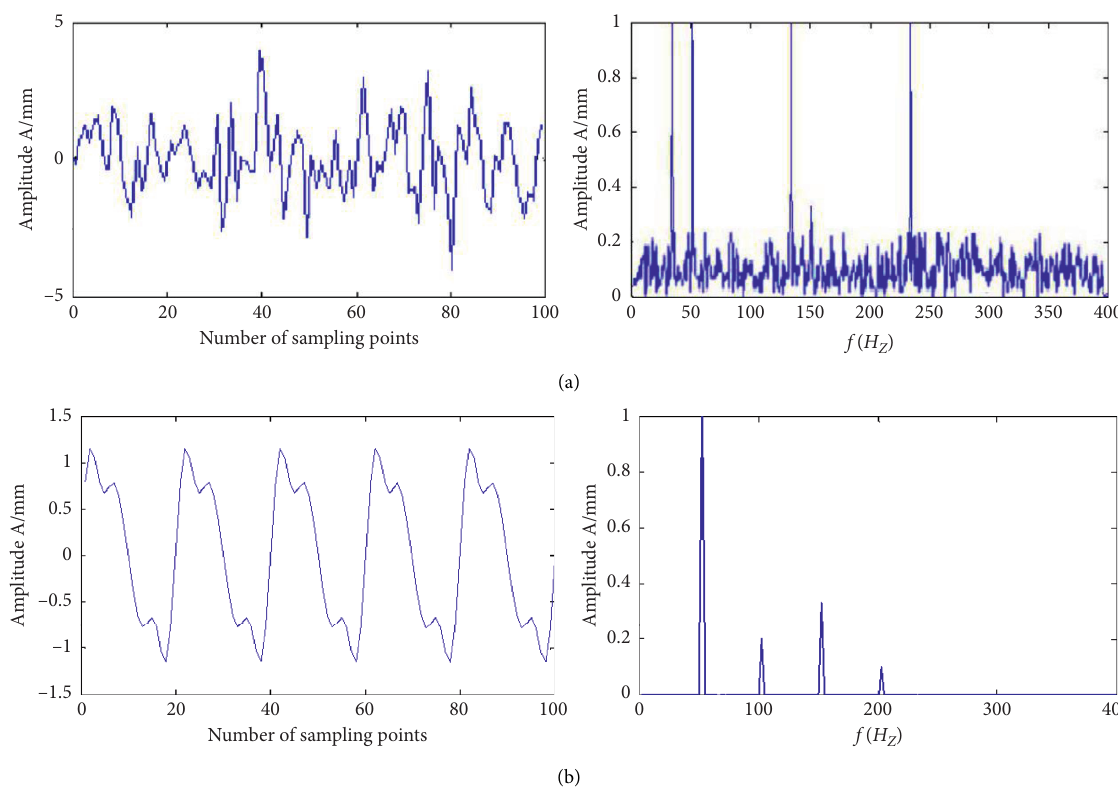
Figure 14: Simulation signal analysis results. (a) Original waveform and spectrum and (b) waveform and spectrum processed by the multiband